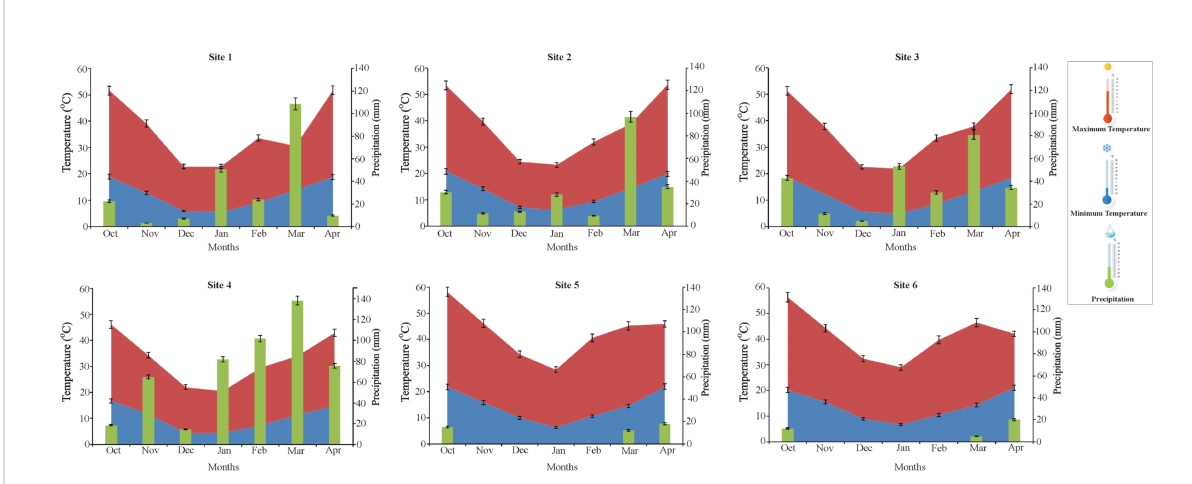
and Site 6: TandoJam.